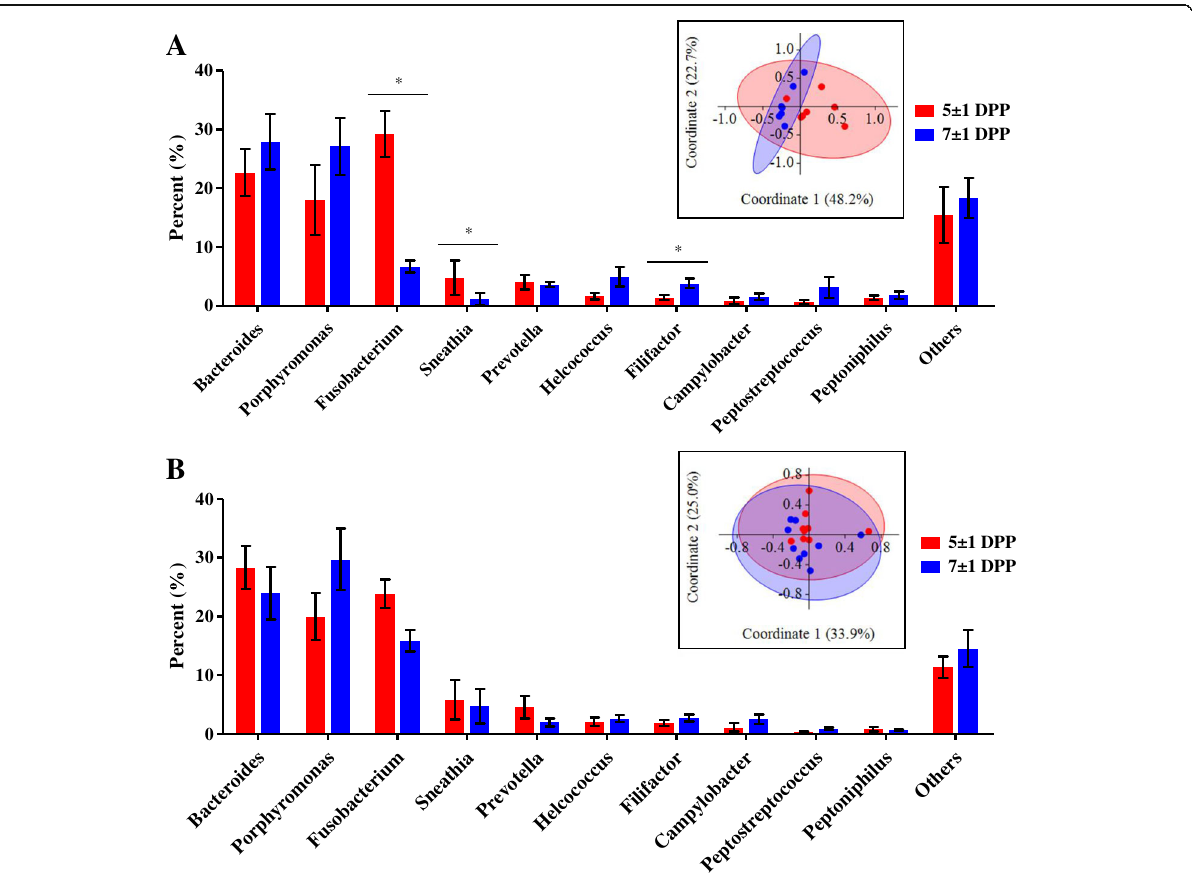
Fig. 2 Uterine microbiota alteration. Relative abundance of bacterial genera (> 1% abundance) and PCoA based on Bray-Curtis distance of genus abundance data with 95% confidence ellipses in a CEF and b CON. Bar graphs represent mean and SEM and significant differences between 5 ± 1 DPP and 7 ± 1 DPP were analyzed using the Wilcoxon signed-rank test ( P ≤ 0.05*). PCoA plots were used to represent the similarity of uterine microbiota, and significant difference between 5 ± 1 DPP and 7 ± 1 DPP was analyzed using PERMANOVA (CEF: P < 0.01, CON: P = 0.09)